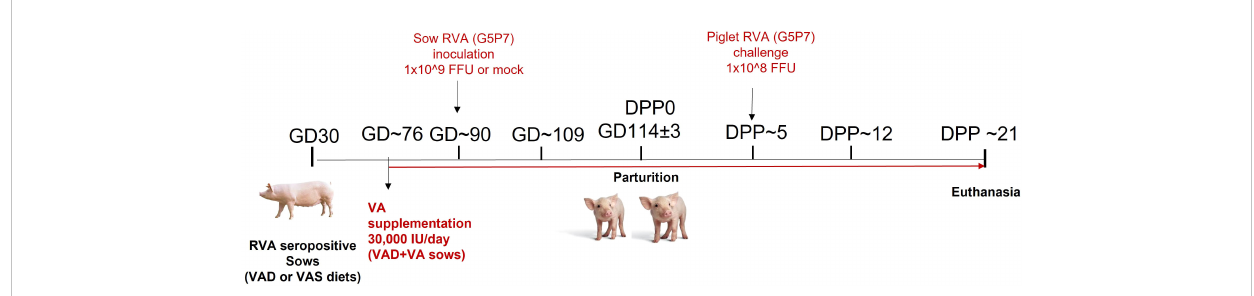
FIGURE 1 Experimental design to evaluate the effects of vitamin A de fi ciency/vitamin A supplementation and RVA inoculation (anamnestic response) on innate and T cell responses of RVA seropositive pregnant sows and passive protection of their piglets. (GD, Gestation Day; DPP, Day Post Partum; VAS, Vitamin A suf fi cient diet; VAD, Vitamin A de fi cient diet; VA, Vitamin A; RVA, Rotavirus